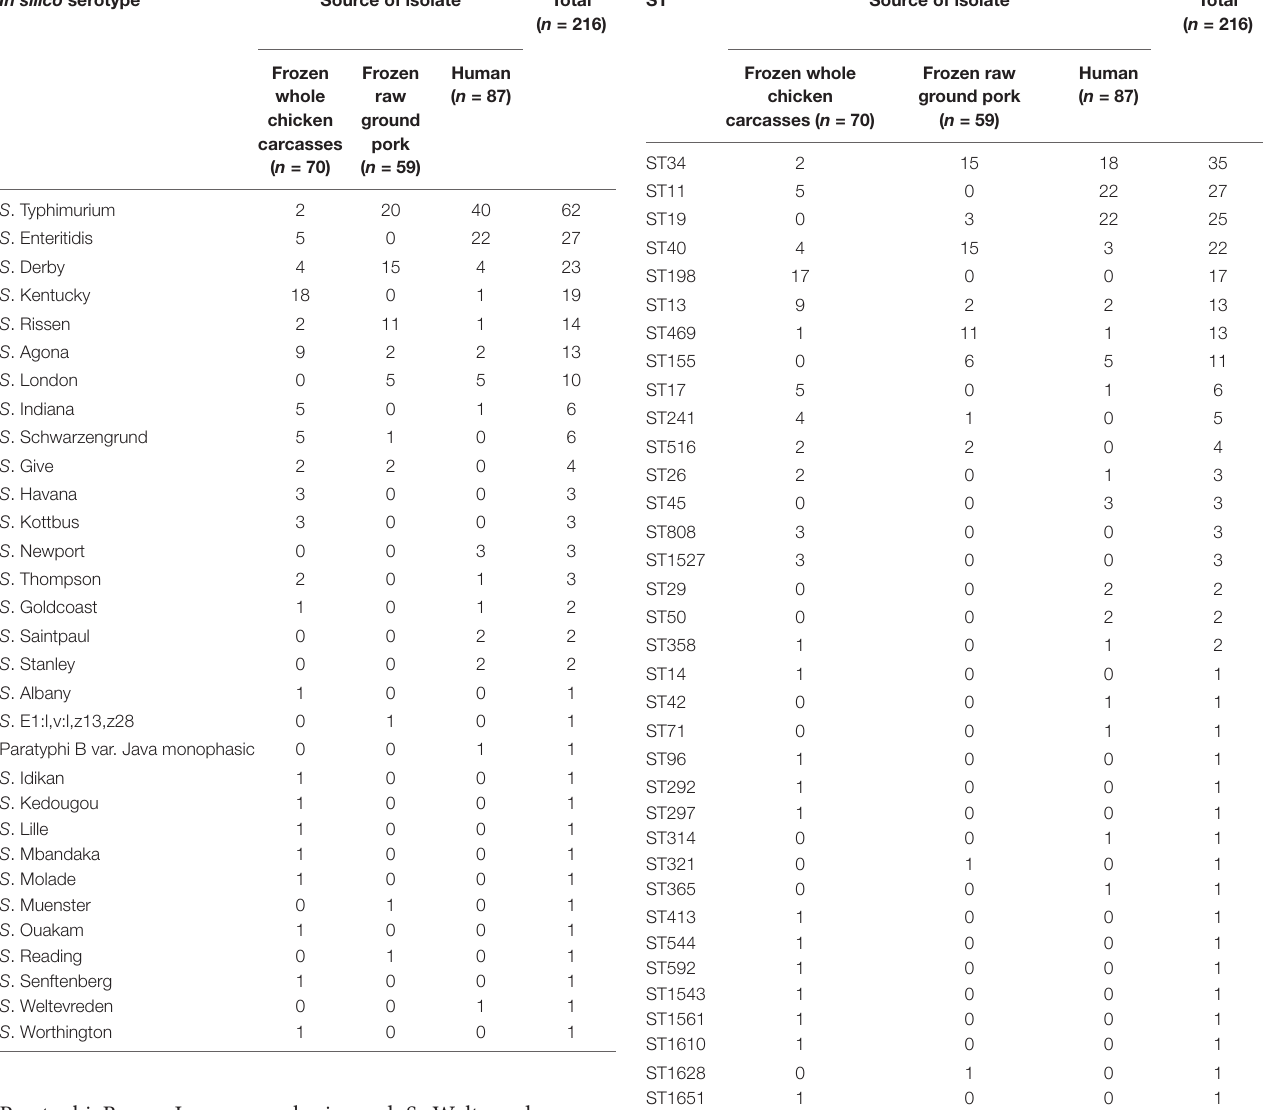
TABLE 3 | In silico serotype and the corresponding number of Salmonella isolates. In silico serotype